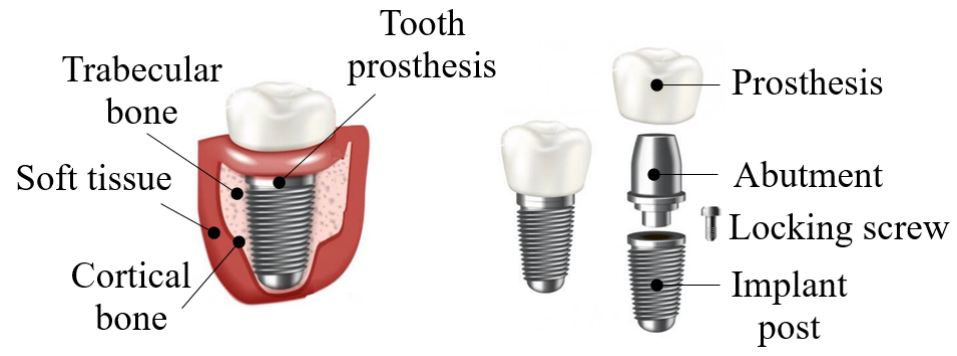
Figure 1. Dental implant with